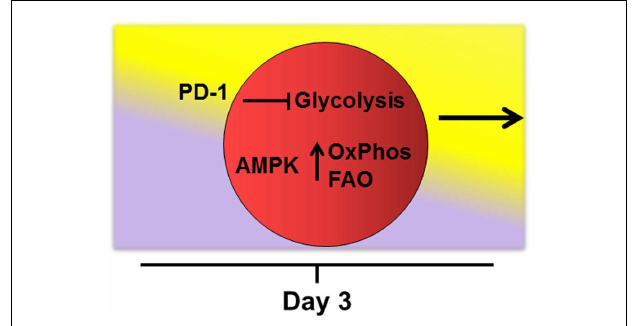
FIGURE 2 | Potential drivers of fatty acid oxidation . Mechanisms that drive transition of robustly activatedT-cells toward oxidative metabolism and fatty acid oxidation remain undefined.The checkpoint molecule PD-1 is upregulated early on allogeneicT-cells and PD-1 expression tracks with levels of reactive oxygen species during GVHD (manuscript in preparation). In addition, signaling through PD-1 is known to restrictT-cell glycolysis (70). AMPK acts as a “cellular energy sensor” and may respond to increasing AMP/ATP ratios as cells proliferate beyond 4–5 cell divisions. AMPK promotes oxidative metabolism (OxPhos) and FAO in multiple systems (36, 37, 71, 72) and knockout of AMPK α 1 increases glycolytic metabolism in T-cells (73).Thus, activated AMPK might simultaneously dampenT-cell glycolysis while promoting adoption of FAO during periods of persistent antigen